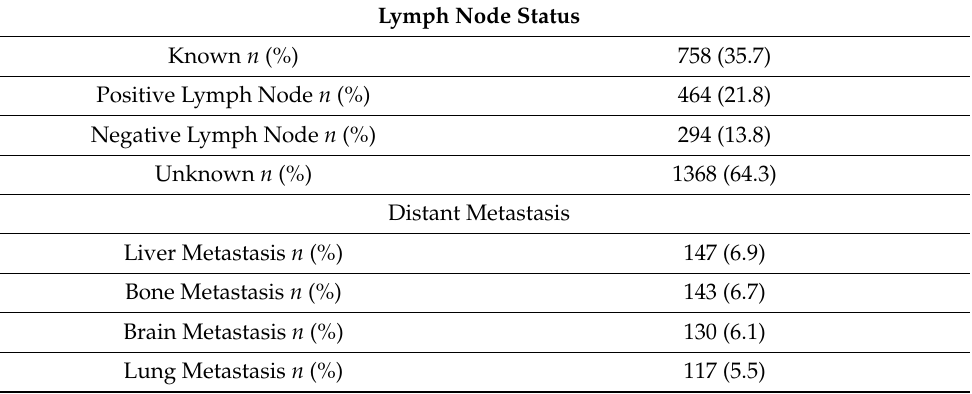
Table 3. Lymph Node Status and Distant Metastasis Location of 2126 Patients with Combined Small- Cell Lung Cancer at the Time of Diagnosis from Surveillance Epidemiology and End Result (SEER) Database (2000–2018).